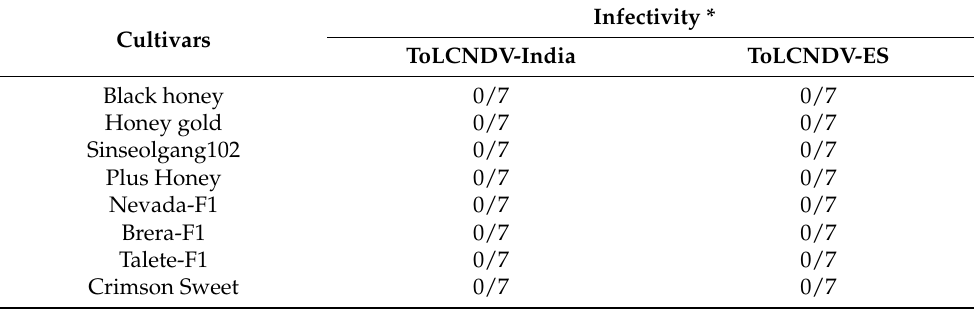
Table 2. Infectivity of two ToLCNDV isolates on different watermelon cultivars.